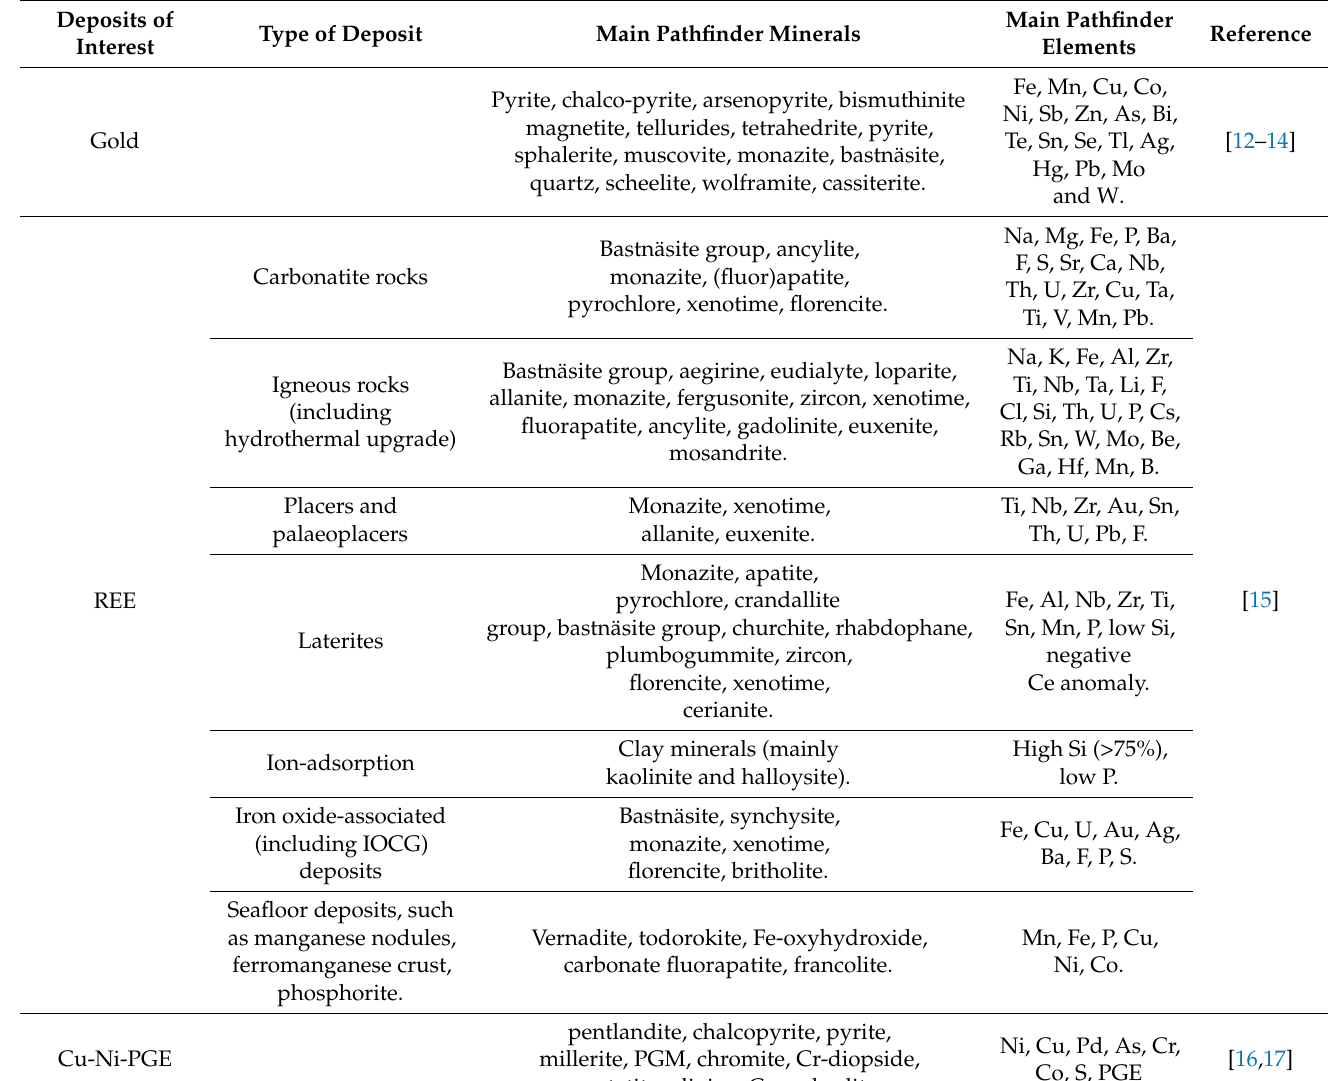
Table 1. Different types of deposits, pathfinding minerals, and